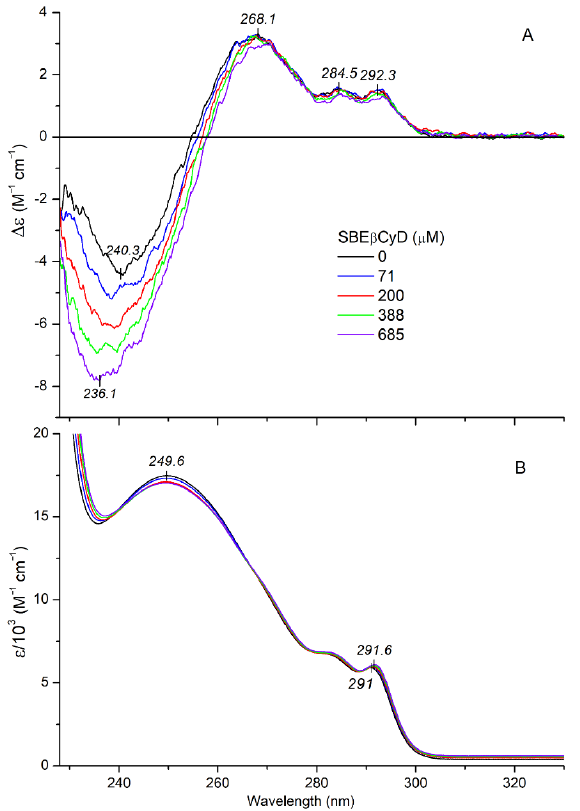
Figure 8. CD ( A ) and absorption ( B ) spectrum of 58 μ M mitragynine measured above 228 nm in aqueous HCl solution (pH ~ 3) at increasing concentrations of SBE β CyD.